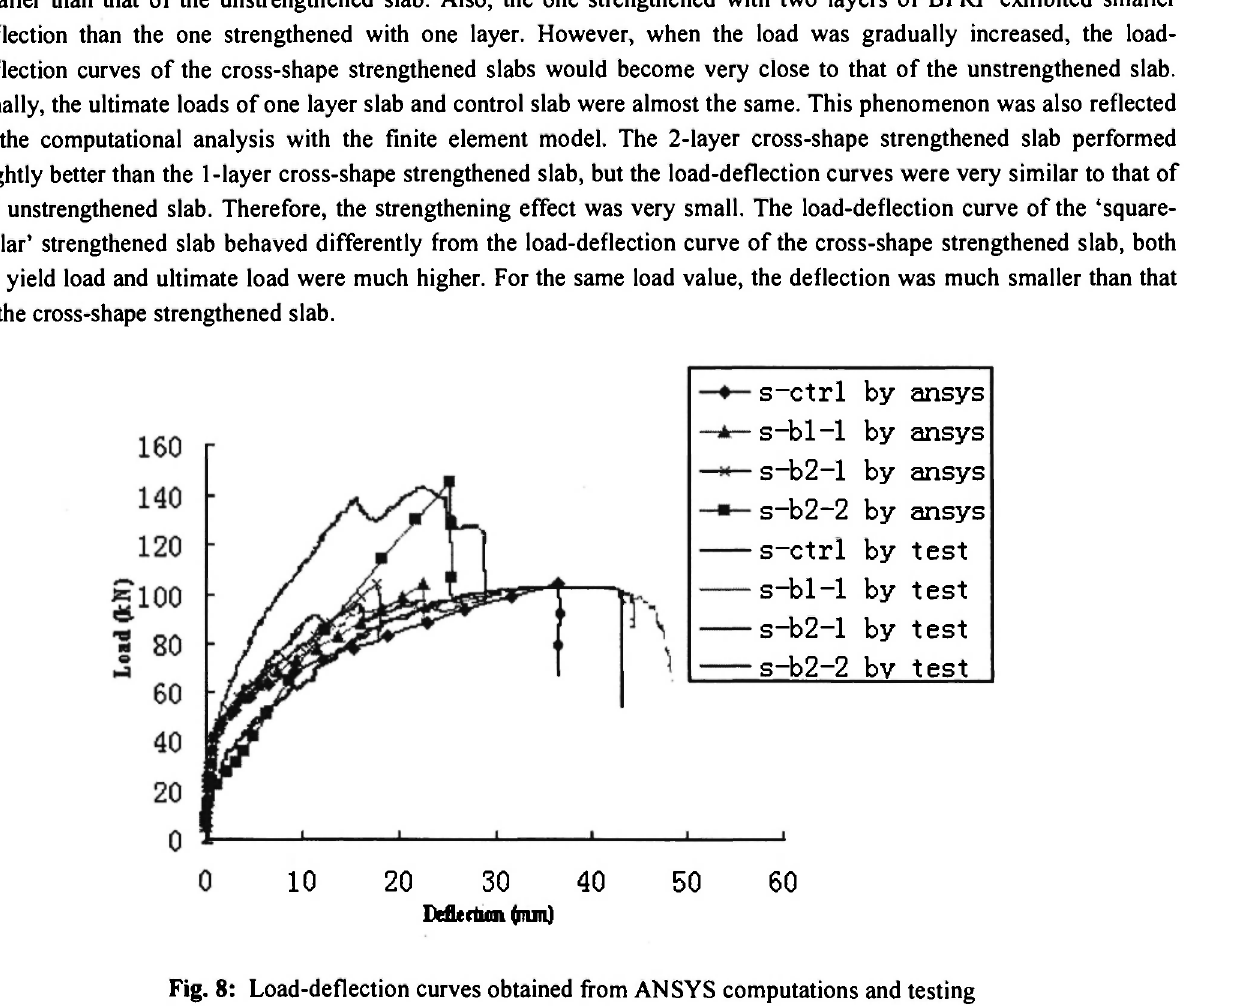
smaller than that of the unstrengthened slab. Also, the one strengthened with two layers of BFRP exhibited smaller deflection than the one strengthened with one layer. However, when the load was gradually increased, the load- deflection curves of the cross-shape strengthened slabs would become very close to that of the unstrengthened slab. Finally, the ultimate loads of one layer slab and control slab were almost the same. This phenomenon was also reflected in the computational analysis with the finite element model. The 2-layer cross-shape strengthened slab performed slightly better than the 1-layer cross-shape strengthened slab, but the load-deflection curves were very similar to that of the unstrengthened slab. Therefore, the strengthening effect was very small. The load-deflection curve of the 'square- collar' strengthened slab behaved differently from the load-deflection curve of the cross-shape strengthened slab, both the yield load and ultimate load were much higher. For the same load value, the deflection was much smaller than that of the cross-shape strengthened slab.